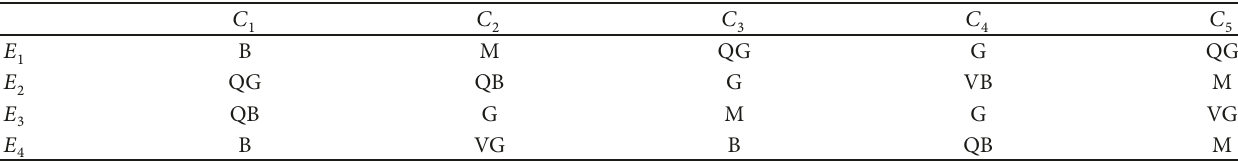
Table 3: The decision matrix 𝐸 1 provided by the 1 st customer.